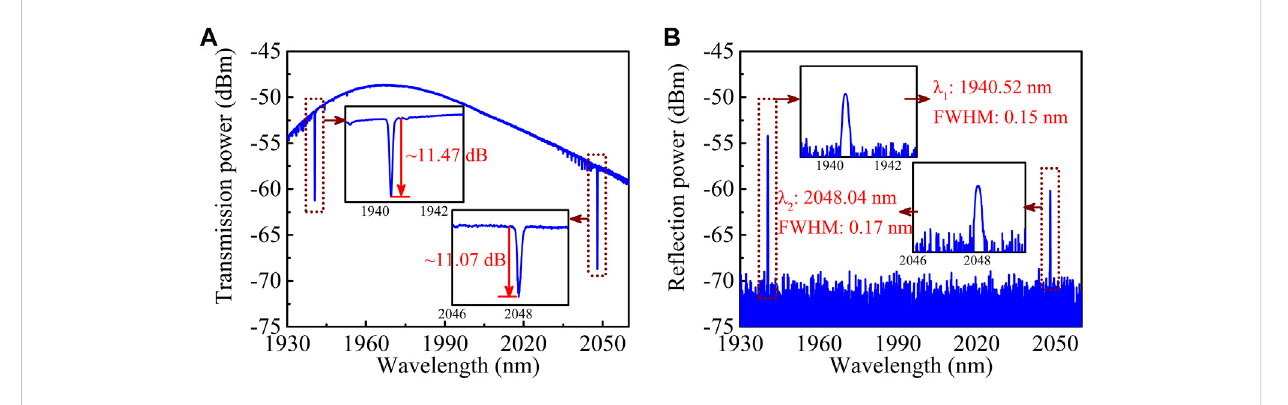
FIGURE 2 (A) Transmission and (B) re fl ection spectra of the